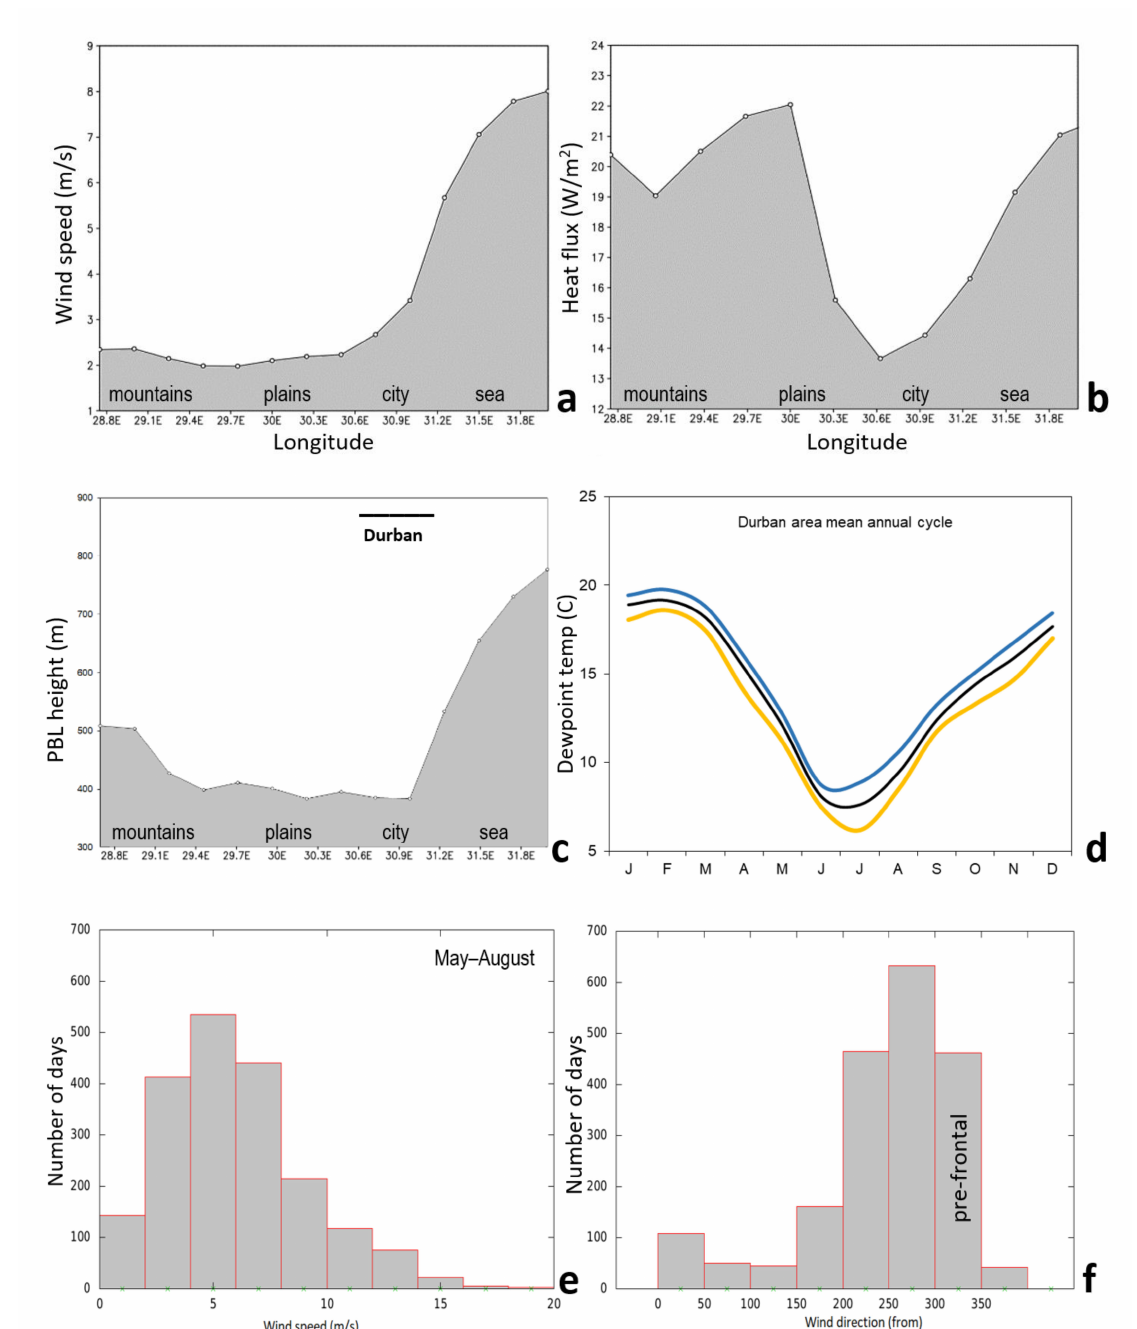
Figure 2. Climatology of atmospheric dispersion via May–August mean longitude slices on 29.8 ◦ S for ERA5: ( a ) surface wind speed, ( b ) sensible heat flux and ( c ) PBL height. ( d ) Mean annual cycle of ERA5 dewpoint temperature. Histograms of Durban-area winter season: ( e , f ) ERA5 near-surface wind speed and direction. In ( a – c ) the longitude of Durban is given